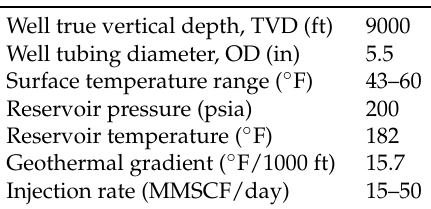
Figure 5. CO 2 pressure within the wellbore versus depth and versus temperature, drawn from the top to the bottom of the well for different tubing head pressure (THP) scenarios. As CO 2 transitions from liquid to gas, a gap appears in the bottom-hole pressure (BHP). Table 1. Properties of the well